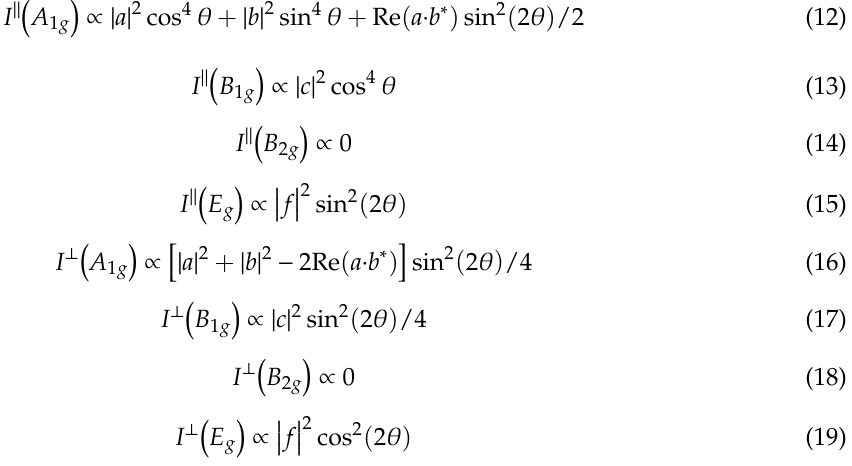
⊥ E  g Figure 7. Polar plots of the angular dependent Raman intensities (cid:3627)𝑒⃑ (cid:3046) ∙ 𝑅⃡∙ 𝑒⃑ (cid:3036) (cid:3627) (cid:2870) of ( a ) A 1g ‐ 1734 cm − 1 , ( b ) B 1g ‐ 1112 cm − 1 and ( c ) E g ‐ 574 cm − 1 modes of the octagon ‐ structure carbon monolayer excited by laser lines 488 nm (green), 532 nm (blue) and 633 nm (red). The polarization